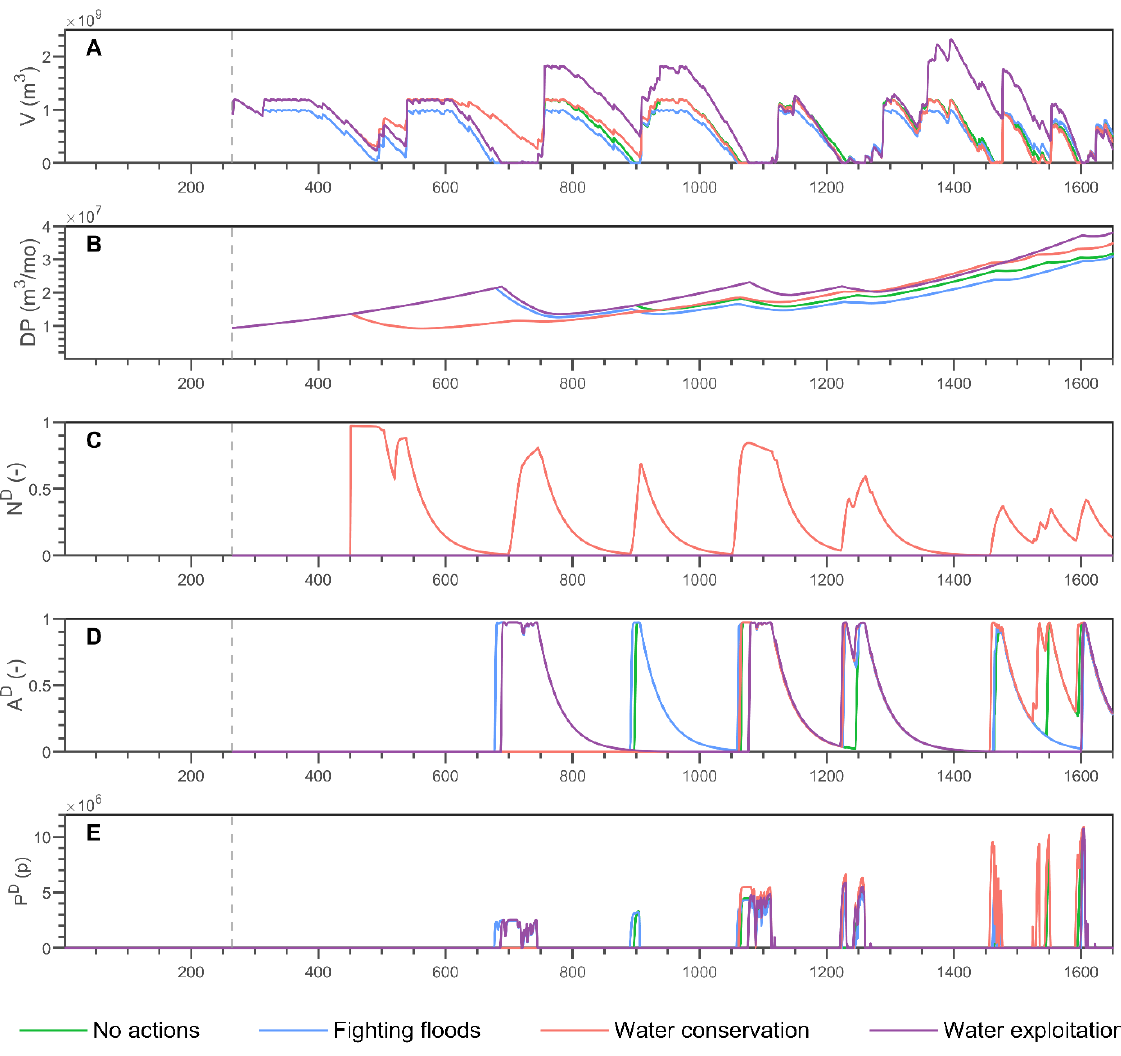
Figure A19. Water shortage-based variables of the synthetic experiments additional scenario #6 considering dam construction and human-flood interactions with the four water management strategies introduced in this study. (A) reservoir volume (V), (B) total water demand (DP), (C) willingness to the new per-capita demand (ND), (D) drought awareness (AD), and (E) population affected by droughts (PD). The grey dashed line indicates the construction of the Wivenhoe